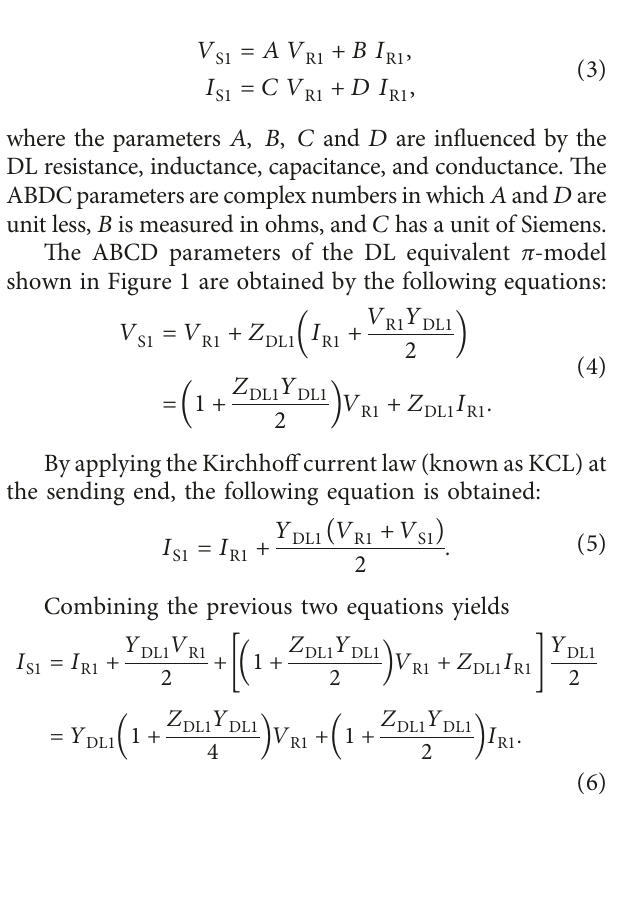
Figure 2: Representation of positive sequence two-port circuit for distribution